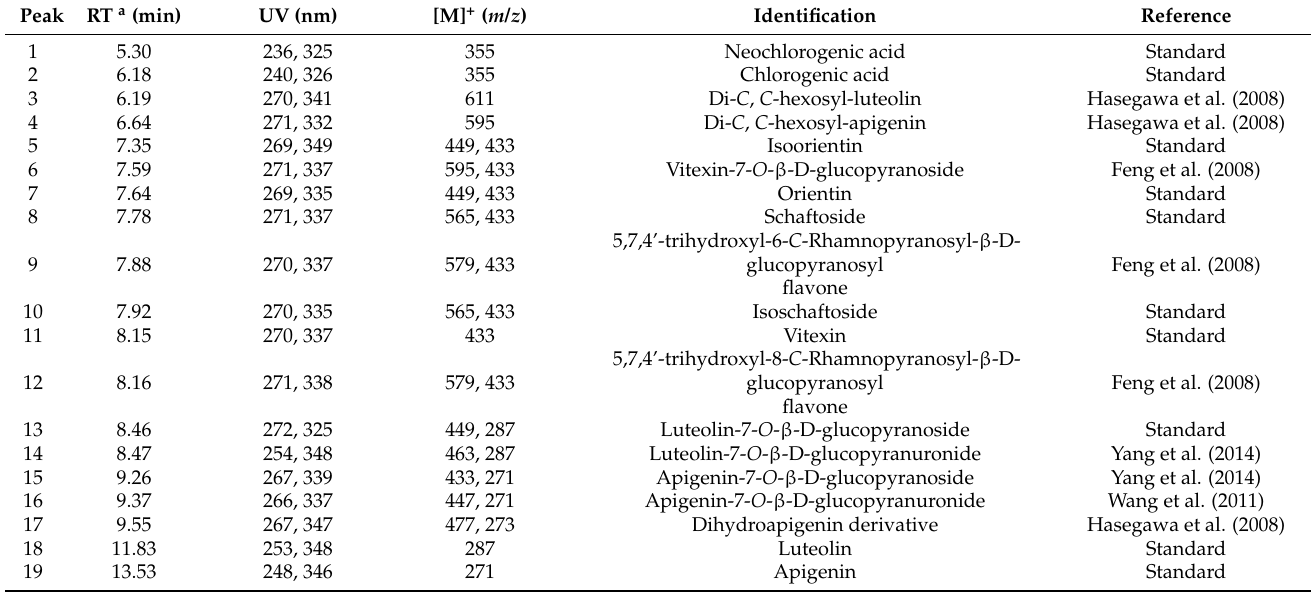
Table 1. The retention time, UV absorption maxima and MS data of the detected compounds from B. kazinoki , B. papyrifera , and B. kazinoki × B. papyrifera